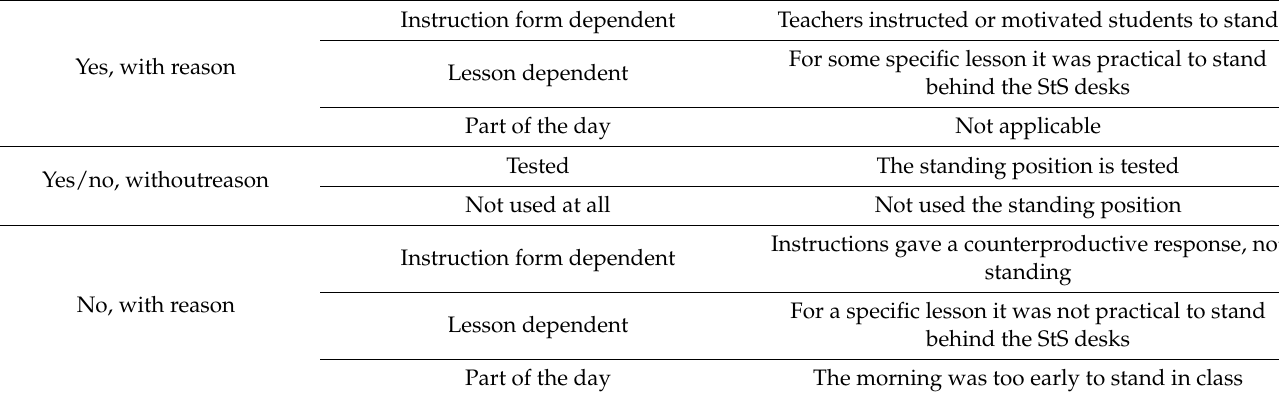
Table 1. Summary of the results for theme 1: Did you or did you not stand behind your sit-to-stand (StS) desk and why? Instruction form dependent Teachers instructed or motivated students to stand For some specific lesson it was practical to stand Yes, with reason Lesson dependent behind the StS desks Part of the day Not applicable Tested The standing position is tested Yes/no, withoutreason Not used at all Not used the standing position Instructions gave a counterproductive response, not Instruction form dependent standing No, with reason Lesson